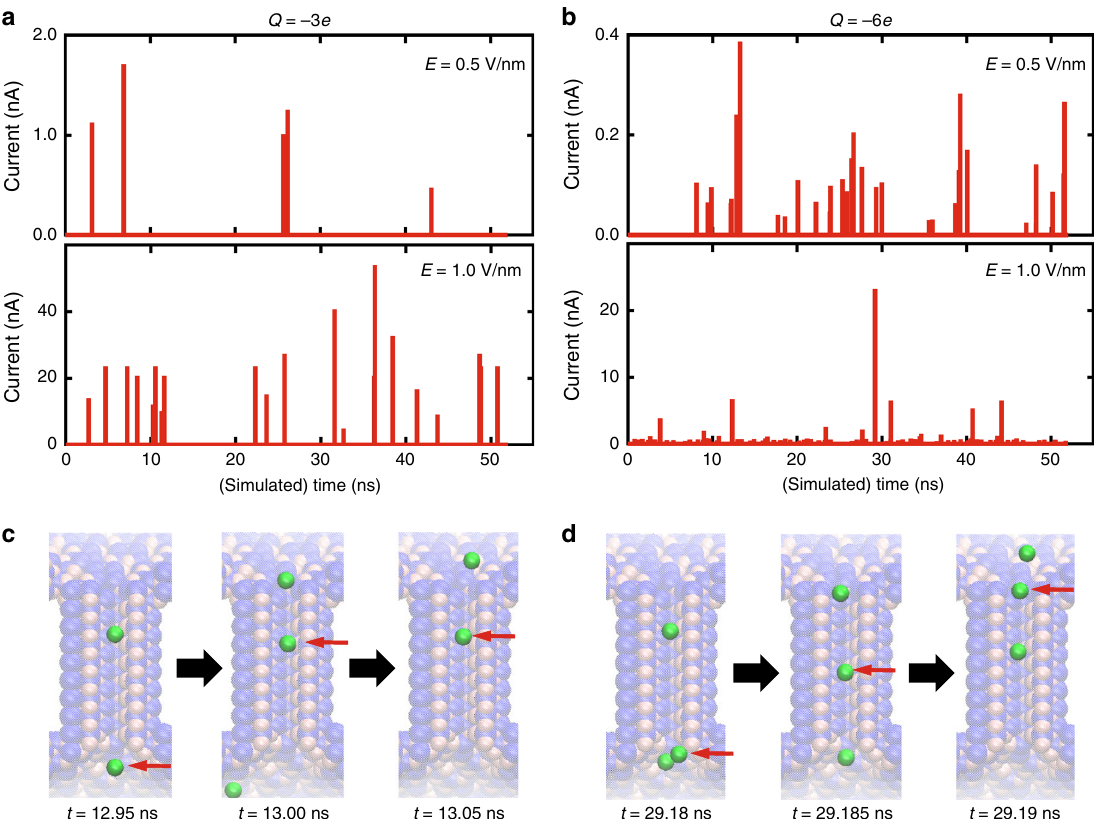
Fig. 3 Visualization of the current through an idealized sub-nanopore accomplished with molecular dynamics (MD). a MD simulations of ionic currents traces through a 0.30 nm-diameter sub-nanopore with the total charge of Q = − 3.0 e in 200 mM NaCl electrolyte are shown for two different electric fi elds: E = 0.5 and 1.0 V nm − 1 . The current spikes represent Na + cations translocating across the membrane through the sub-nanopore, and the magnitude of spikes is related to the duration of the translocation. b Like a , but with a total charge of Q = − 6.0 e . With increasingly negative Q , translocations are observed more frequently and the magnitude of the current spikes increases in the higher electric fi eld. c Snapshots extracted from the MD simulation are shown illustrating the trajectories of ions through the idealized sub-nanopore at E = 0.5 V nm − 1 . At this low fi eld, the ion trajectory was governed essentially by the electric fi eld and single ions approach the ori fi ce one-at-a-time. The red arrows track the same ion. d Like c , but for a larger electric fi eld (1 V nm − 1 ). Now, the ion traf fi c near the ori fi ce becomes congested with one ion accelerating the translocation of another through the pore via